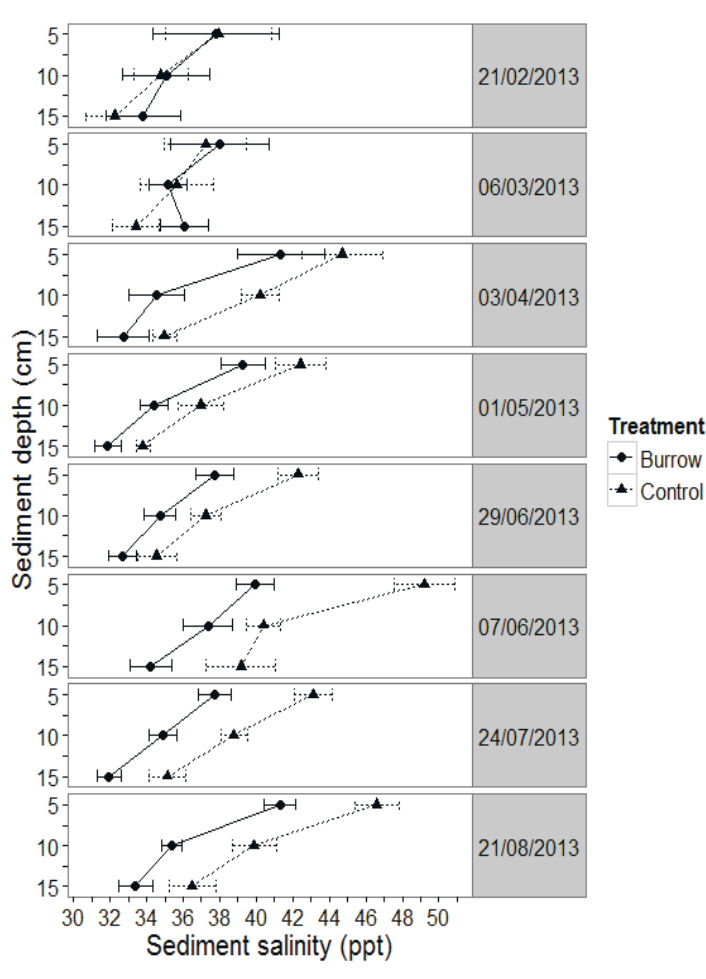
Figure 3. Mean sediment salinity ( n = 9 for each treatment) inside the plant containers for three sediment depths (5, 10, and 15 cm) from the first sampling (21 February 2013) to the last sampling (21 August 2013). Treatments are indicated by different point and line types. Error bars represent the standard error